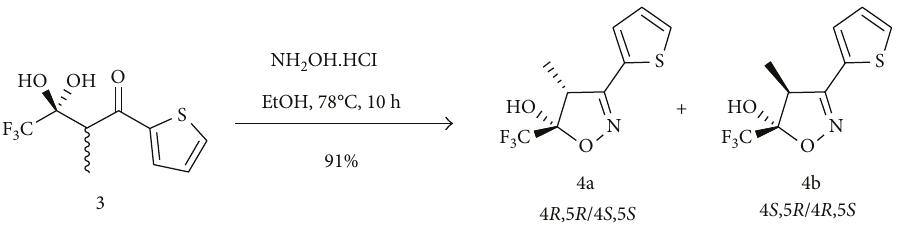
Scheme 2: Cyclocondensation between 4,4,4-tri fl uoro-3,3-dihydroxy-2-methyl-1-(thien-2-yl)butan-1-one (3) and hydroxylamine hydrochloride.